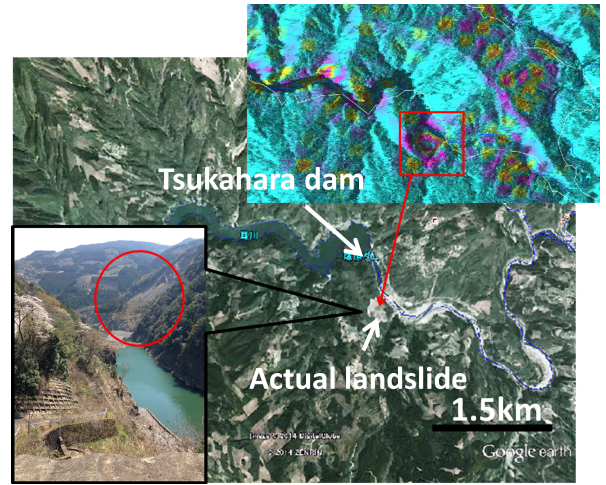
Figure 5. Collapse to the south of Tsukahara dam was extracted from ascending PALSAR image. (Base map is from Google earth)